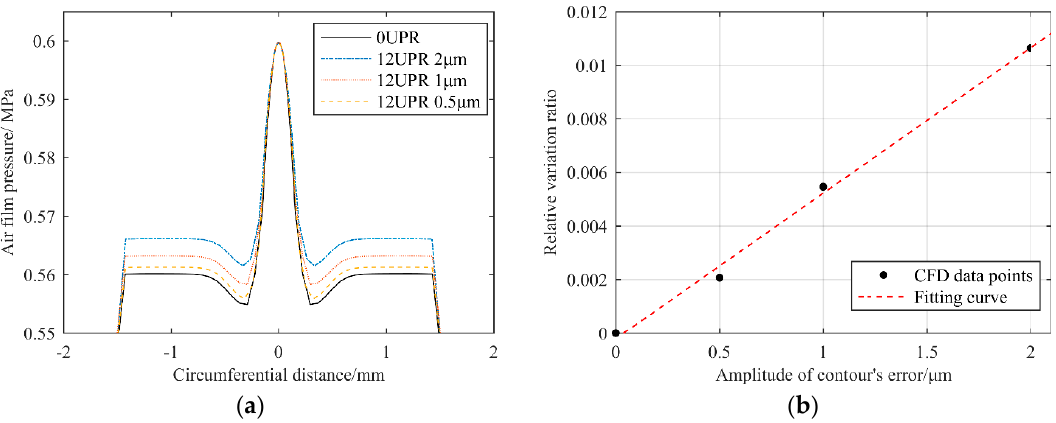
Figure 9. Comparison of CFD results for different error amplitudes when the frequency was fixed at 12 UPR: ( a ) comparison of pressure distribution at the orifice chamber; ( b ) relative variation ratio of the film’s pressure.